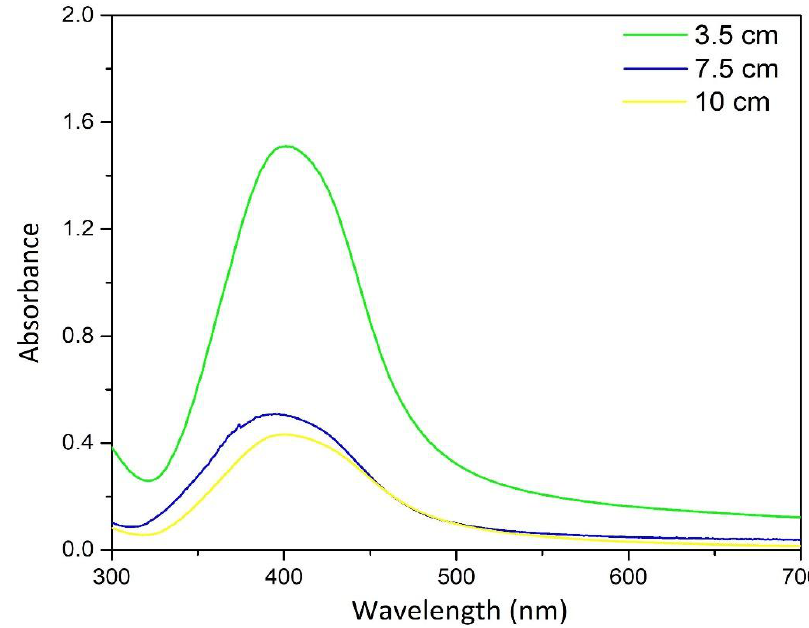
Figure 3. The effect of the distance between the UV irradiation source and sample on AgNP synthesis.